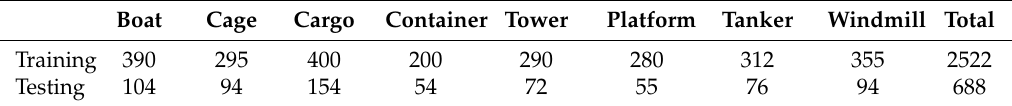
Table 2. Composition of the marine target classification dataset.